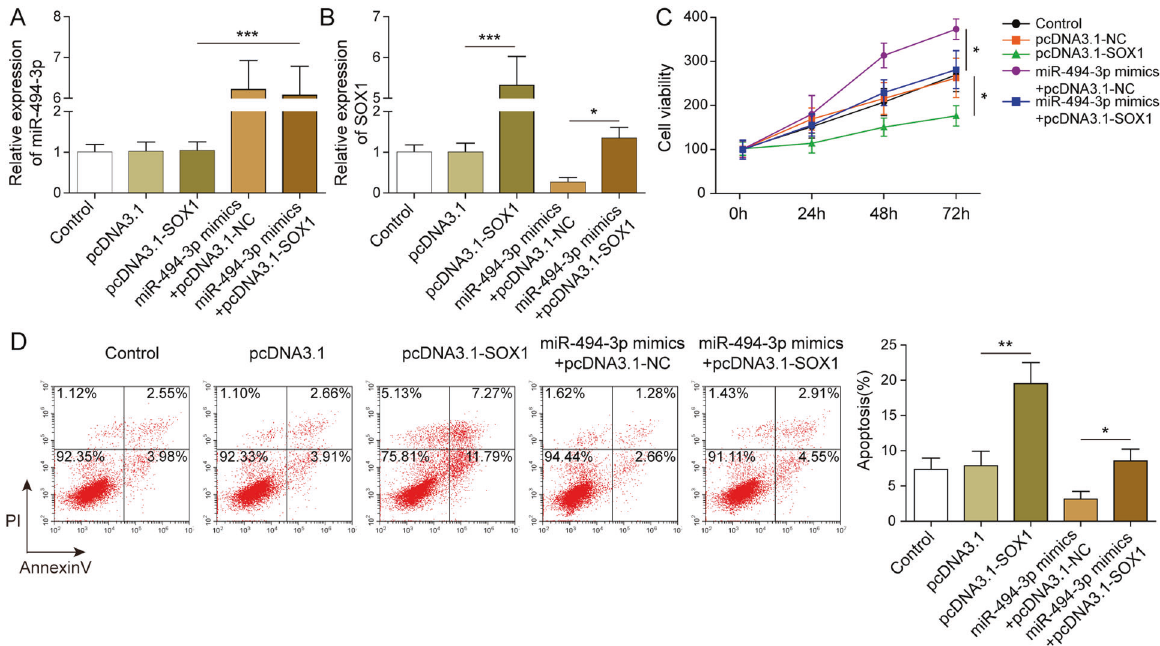
Fig. 5 miR-494-3p induced T-ALL cell proliferation by targeting SOX1. A , B RT-qPCR detection showed that miR-494-3p targeted SOX1. C , D MTT and fl ow cytometry investigation revealed miR-494-3p promoted the viability and inhibited the apoptosis of T-ALL cells via targeting SOX1. The quantitative values are expressed as a mean ± SD from three independent experiments. * P < 0.05, ** P < 0.01, *** P < 0.001.